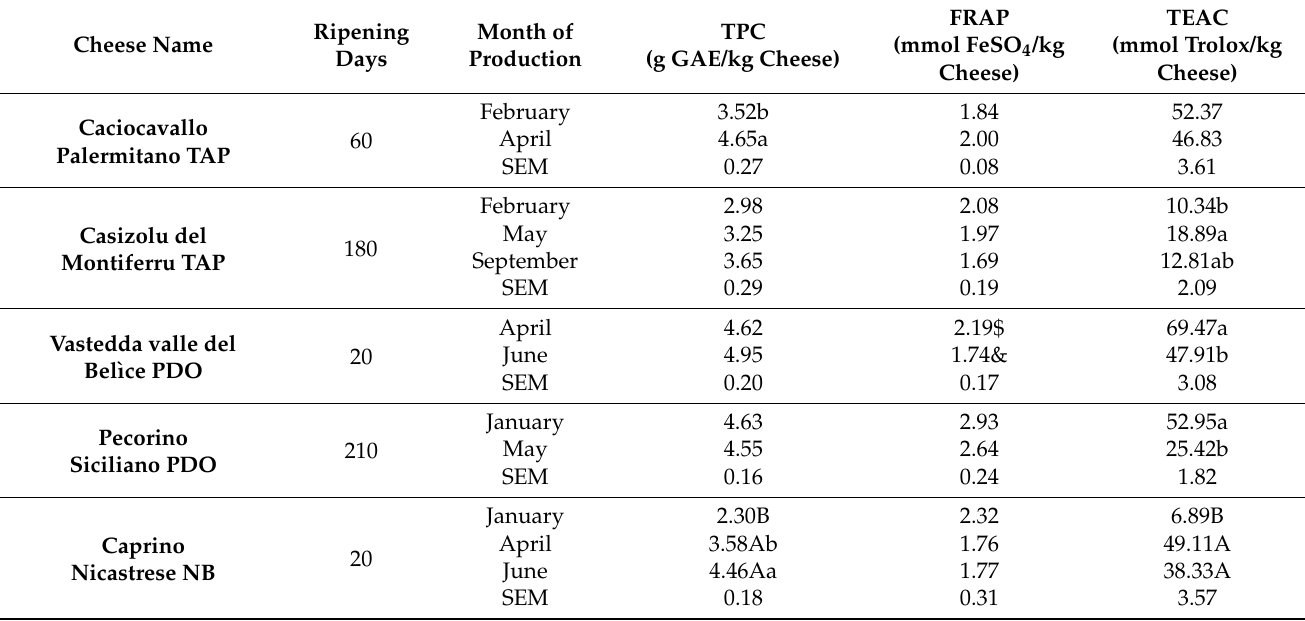
Table 4. Effect of the month of production on the total polyphenol content and the total antioxidant capacity of the AGER selection